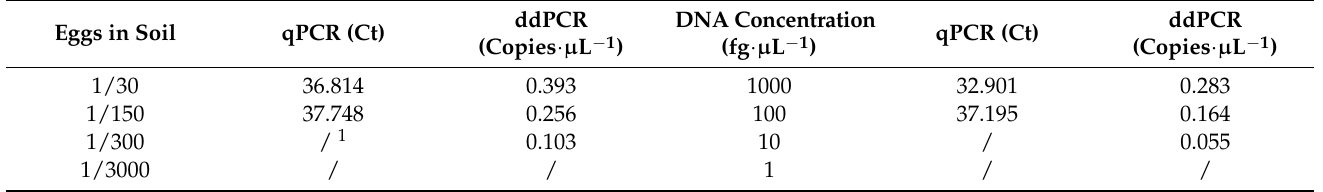
Table 2. The minimum threshold for identification of M. enterolobii detected by qPCR and ddPCR